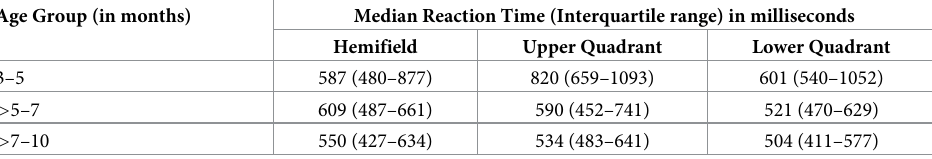
Table 2. Median reaction time to gross visual field